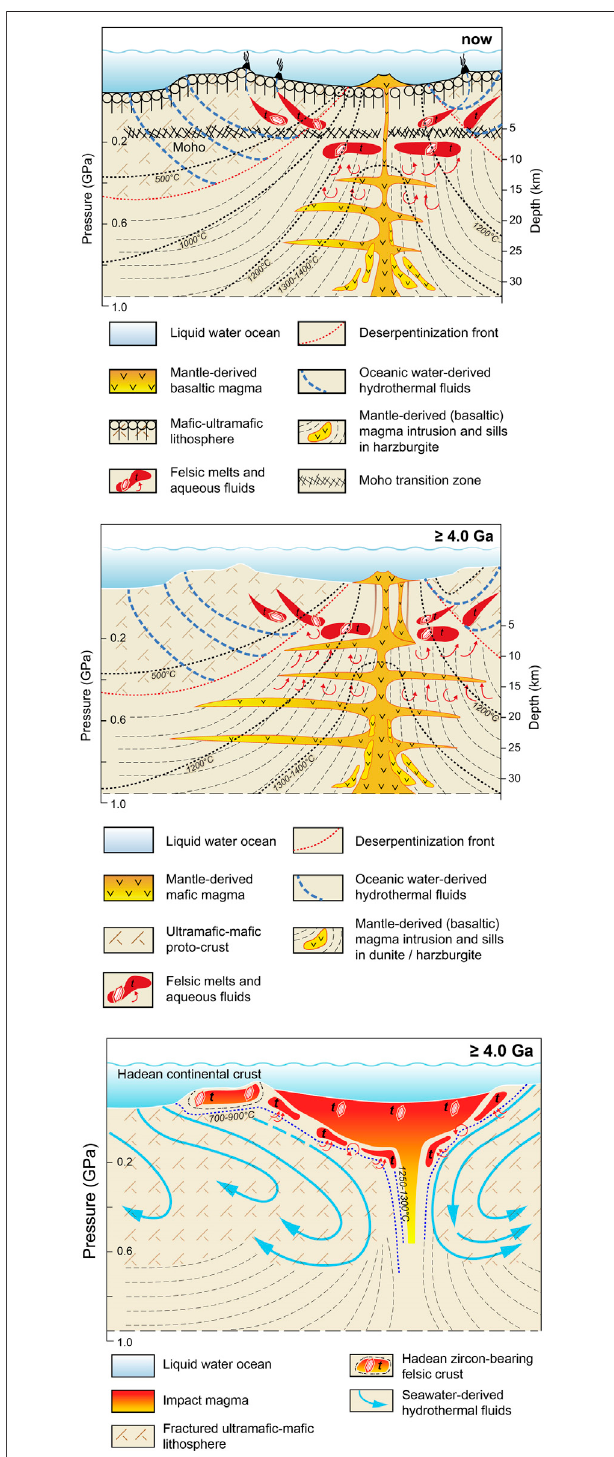
FIGURE 8 | Upper panel: Model for the formation of shallow felsic crust in mantle peridotites of the oceanic lithosphere. Dehydration is initiated by the intrusion of mantle-derived magmas into hydrated (serpentinized) mantle. The released fl uid promotes fertilization and partialmeltingofthe peridotite, which leadstoproduction ofTTG magmas